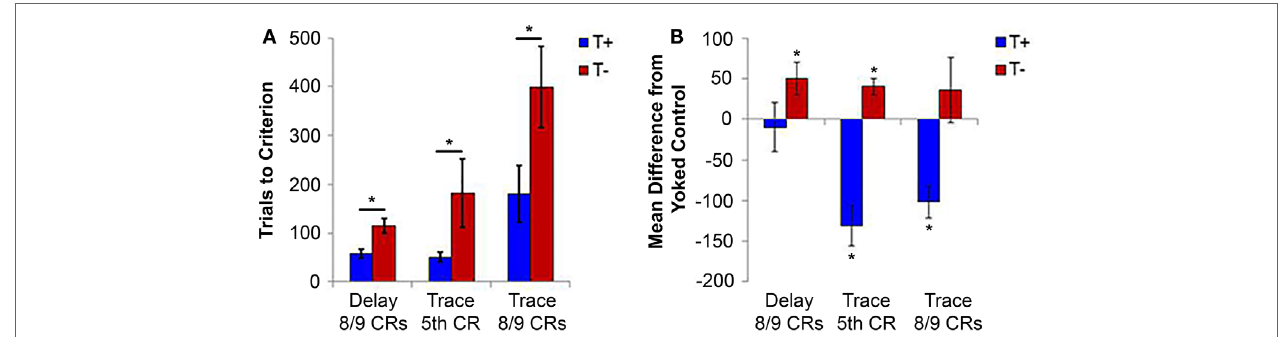
FiGURe 2 | (A) Average number of trials required to reach behavioral criteria in delay (8/9 CRs) and trace (fifth CR and 8/9 CRs) forms of EBC. Animals trained under T − conditions required significantly more trials than T + animals to reach asymptotic performance (8/9 CRs) in delay conditioning, as well as more trials to reach early (fifth CR) and asymptotic (8/9 CRs) behavioral markers. (B) Average difference in the number of trials to reach behavioral criteria from yoked controls. T − animals needed more trials than controls to reach asymptotic performance of delay conditioning and more trials to reach the early learning criteria of trace conditioning. The differences from yoked controls provide evidence of detrimental performance in the T − condition, showing that T − /T + differences are not simply an effect of improved performance in the T + condition. * p < 0.05. Delay figures adjusted from Seager et al. (144), trace figures adjusted from Griffin et al.